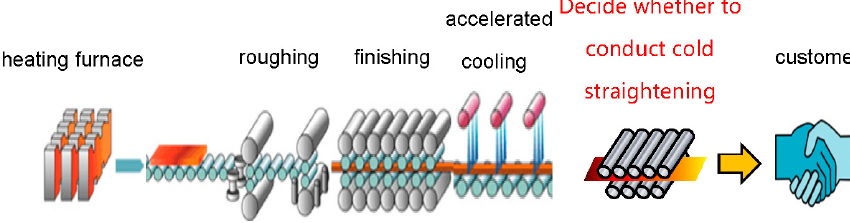
Figure 1. Steel plate manufacturing process.